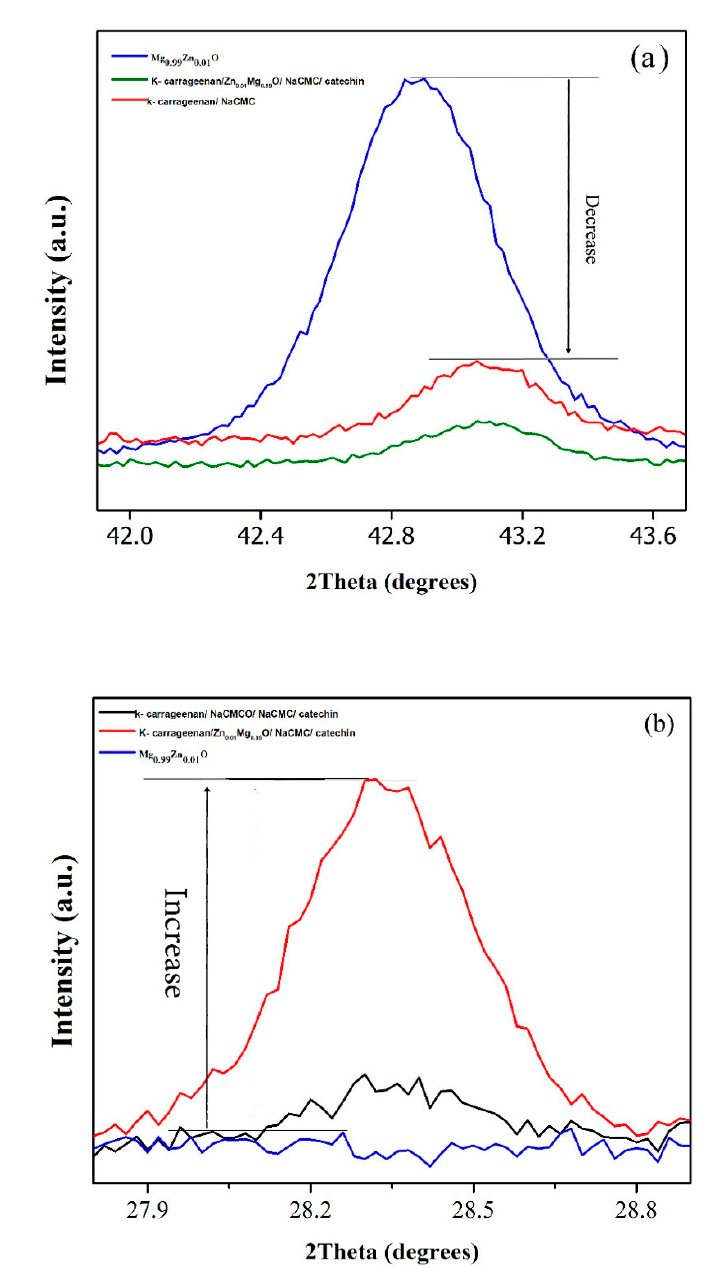
Figure 4. XRD peak related to ( a ) MgO cubic and ( b ) ZnO hexagonal structures .